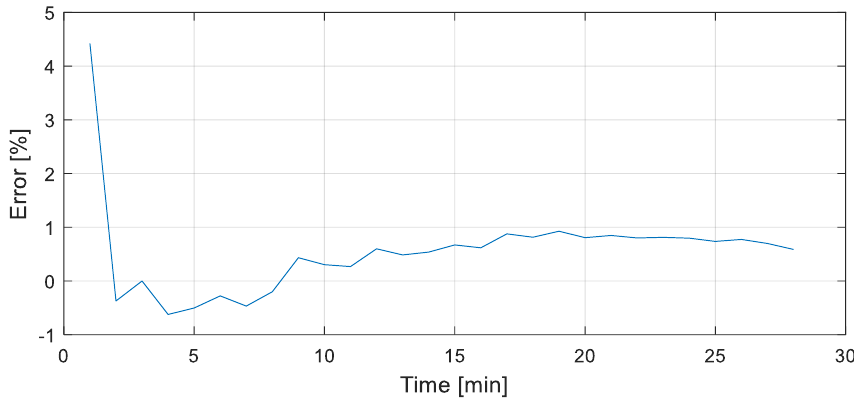
Figure 10. Temperature comparison — [location ID: web2].